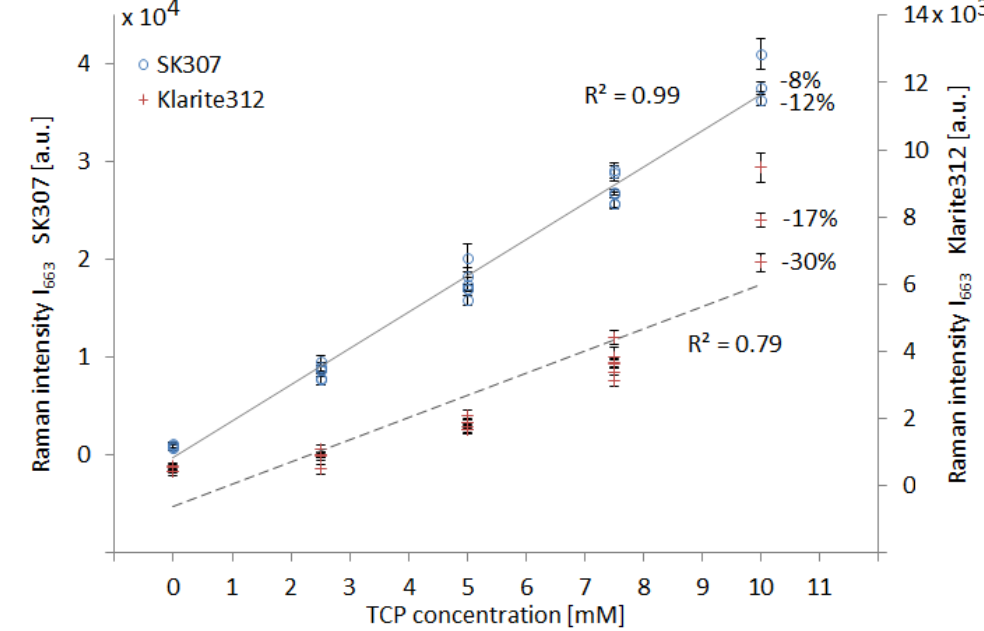
Figure 7. Comparison of TCP signal from SERS substrates Klarite 312 and SK307. Dependence of Raman signal intensity on TCP concentration. Raman intensity I 663 represents the Raman signal magnitude at the indicated Raman shift. With Klarite 312, the response is not linear and the signal decays by 30% within 3 cycles. SK307 has nearly linear response and the signal decreases by only 12% within 3 cycles. This represents signal degradation 26% per hour. The linear regression (grey lines) yielded the regression coefficients R 2 . Their magnitude is proportional to the linearity of the data distribution. Each data point was averaged from 6 measurements. Error bars: 95% confidence